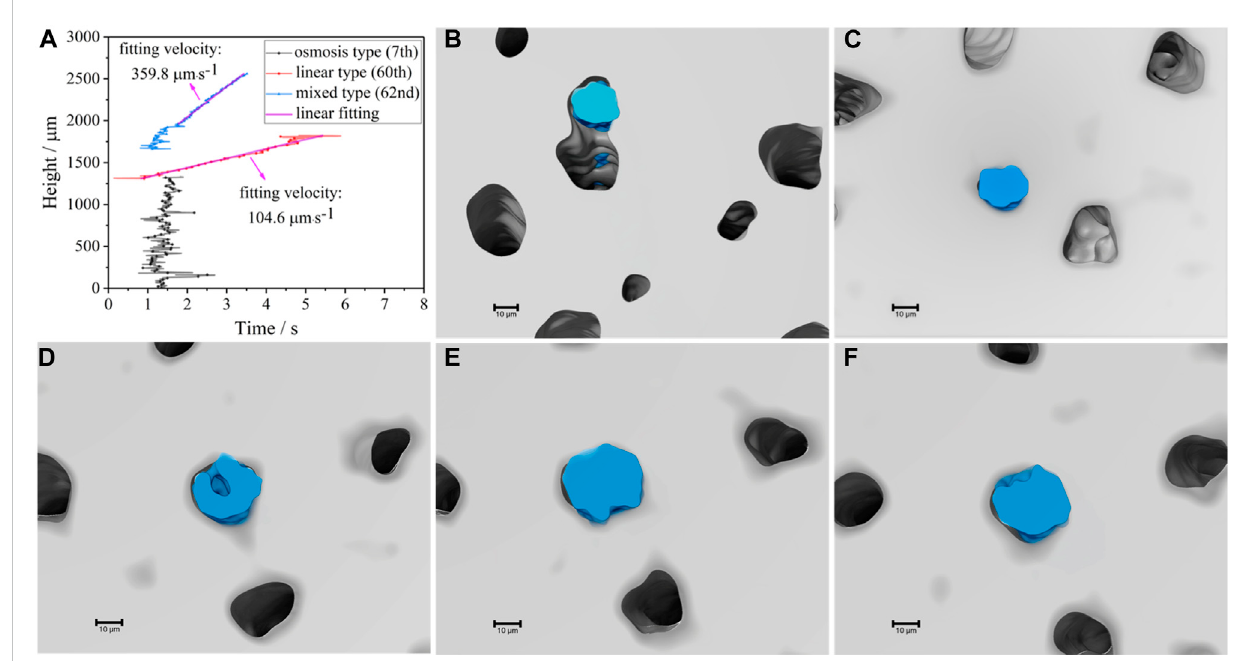
FIGURE 3 Three typical modalities of water re fi lling along vessels. (A) Position vs. time curves for the three typical modalities and the velocities after linear fi tting. (B – F) FusedimagesofCTandMCXCTatpositionsofthevessels , withthegrayscaleindicating themicrostructureofthevesselssurroundedbythe tissues, and the blue denoting the re fi lled water reconstructed by MCXCT. (B) Cross section at 895 μ m corresponding to the black curve in (A) . (C) Red curve at 1,400 μ m (D) Blue curve at 1,875 μ m. (E) Blue curve at 2,000 μ m (F) Blue curve at 2,200 μ